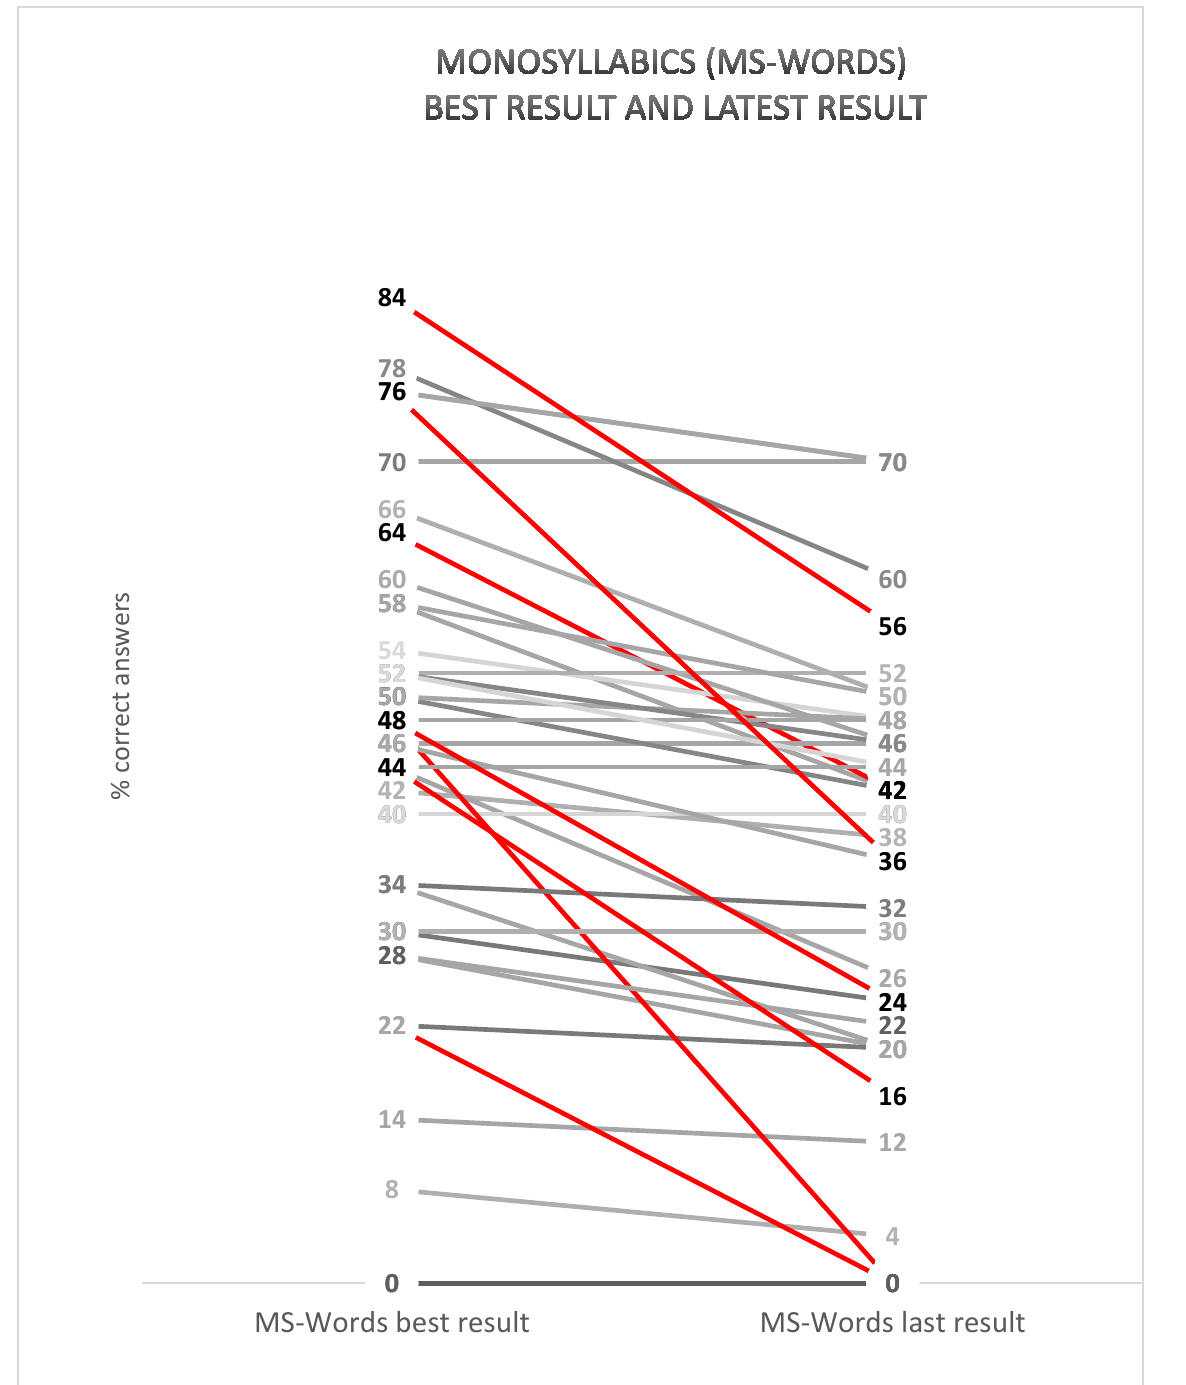
Figure 3. MS words best score and MS words at the latest visit to the clinic for all patients in the study. Patients marked with a red line have a decline in the score of more than 20 percentage points. Table 1. Patients with a change in monosyllabic score of more than 20 percentage points between best and latest measure, their daily CI usage, EQ5D VAS score, index value (NA = no answer) , age, and sex.